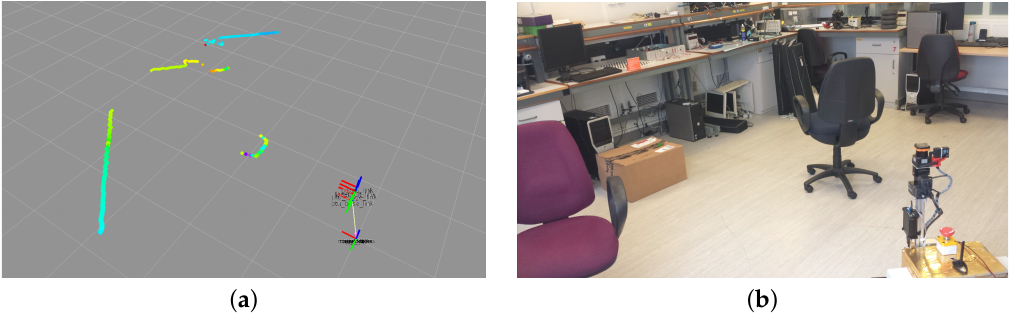
Figure 8. Single line of LIDAR data points ( a ) of the indoor laboratory setup ( b ).